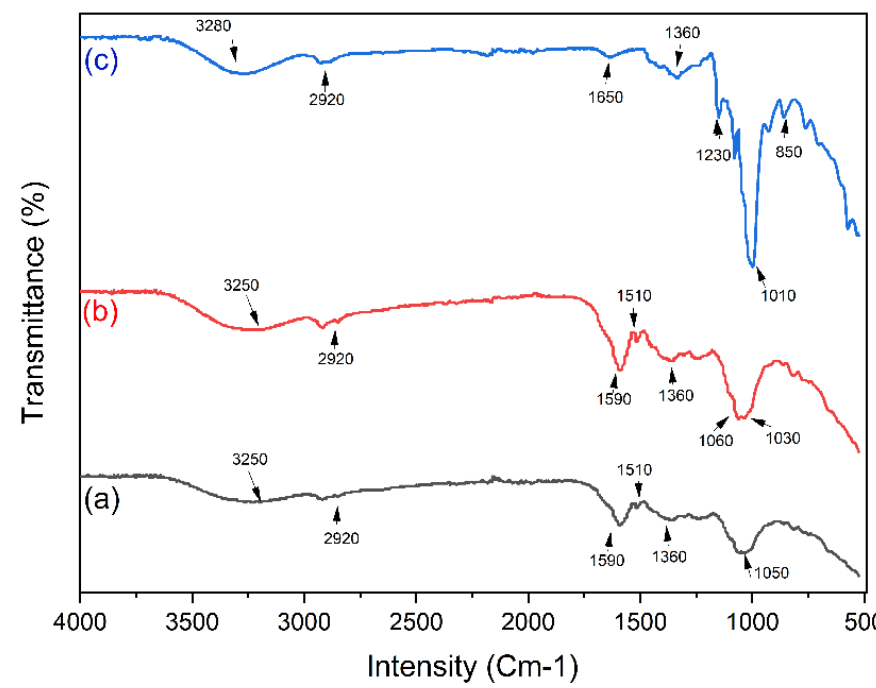
Figure 1. FTIR of (a) CQDs, (b) S-CQDs, and (c) S-CQDs/starch.